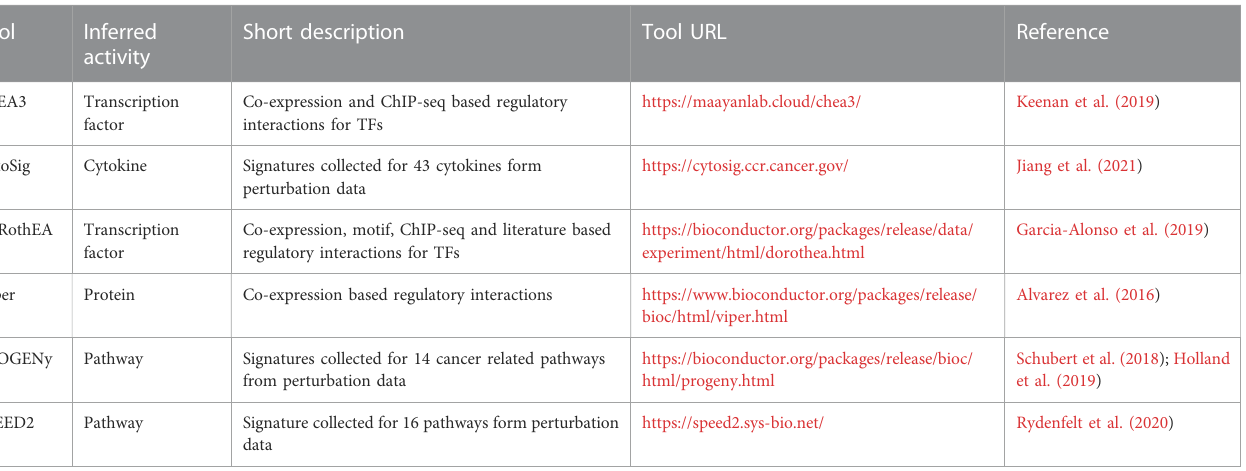
TABLE 2 Computational tools for footprint based pathway activity